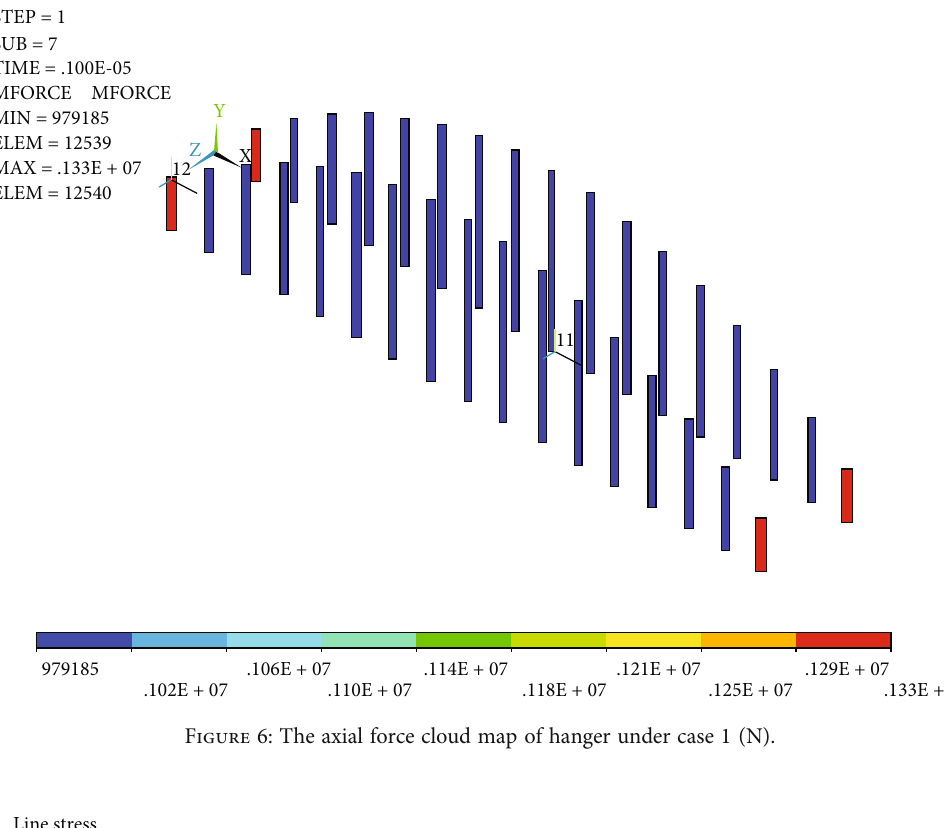
Figure 6: The axial force cloud map of hanger under case 1 (N).